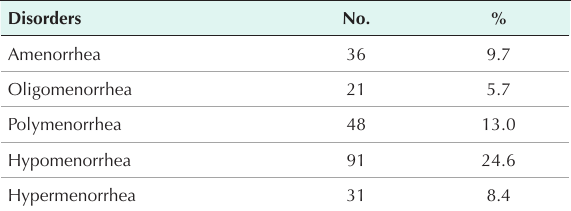
Table 2. Incidence of Menstrual Disorders Disorders